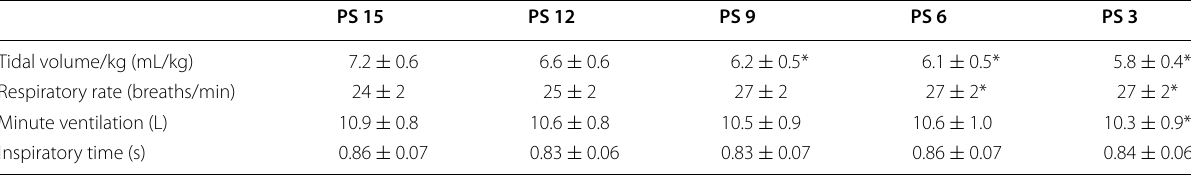
Values are represented as mean PS pressure support level